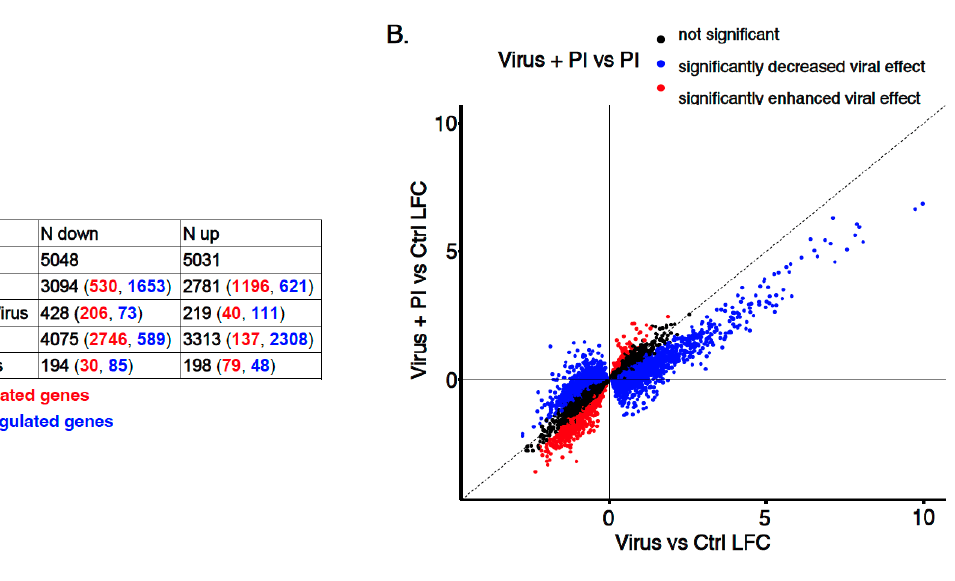
Figure 6. Differential gene expression analysis in RV-A16-infected human AECs with or without lipid treatment. ( A ) The number of up- and downregulated genes for the comparisons is indicated in the table. The numbers in parentheses show the number of upregulated (red) and downregulated (blue) RV-A16 response genes within the respective comparison. ( B ) Scatter plot of 10,079 DE RV-A16 response genes. RV-A16 response genes whose expression was opposed by PI are highlighted in blue (2746 + 2308 genes), and those enhanced by PI are highlighted in red (589 + 137 genes). Differential expression analyses were performed using the lmerSeq package.